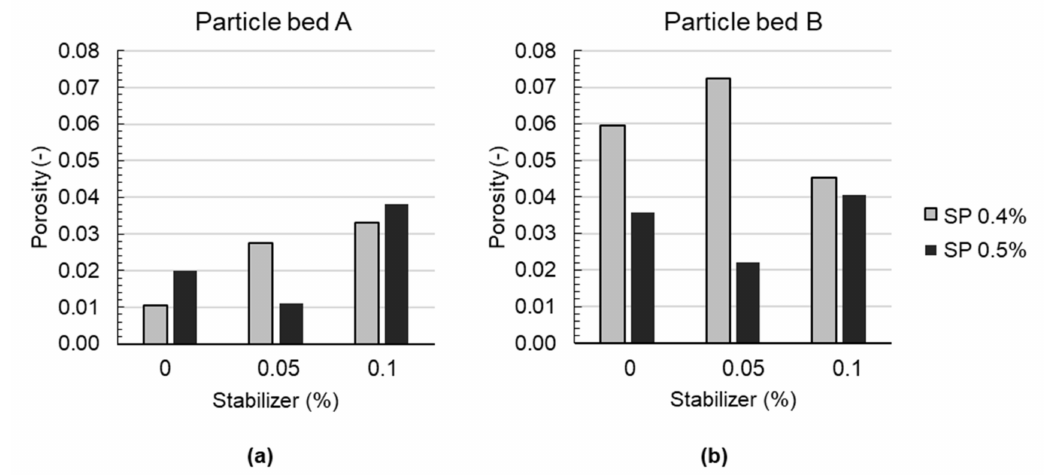
Figure 9. Results of porosity determination with µ CT of drilling cores from LP3DCP specimens for ( a ) particle bed A and ( b ) particle bed B.